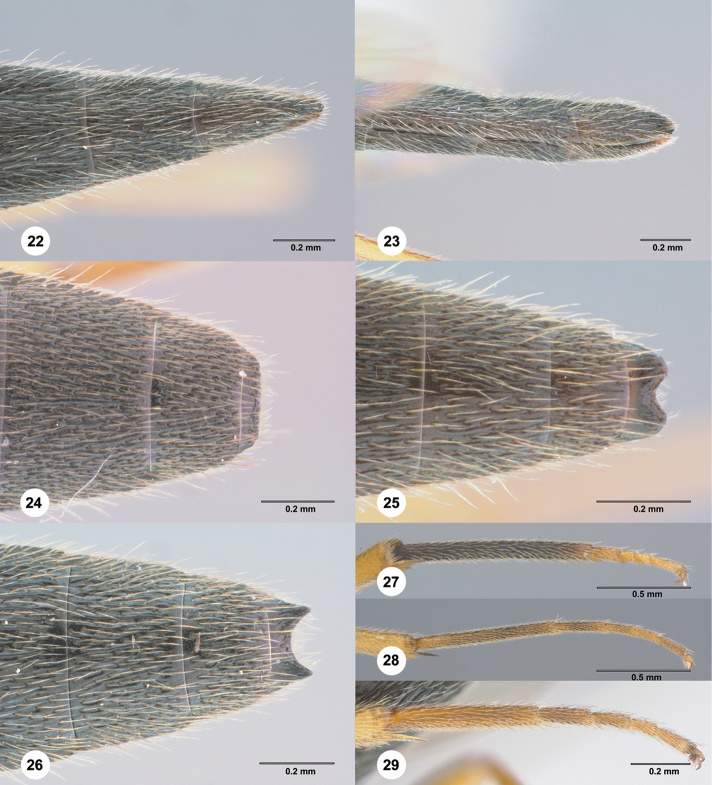
22–23Chromoteleiafuscicornis Kieffer, female (OSUC584322). 22 Apical metasoma, dorsal view 23 Apical metasoma, lateral view 24Chromoteleialongitarsis Kieffer, male, holotype (CAS TYPE9682), apical metasoma, dorsal view 25Chromoteleiafuscicornis Kieffer, male (OSUC586417), apical metasoma, dorsal view 26Chromoteleiabidens sp. n., male, paratype (OSUC577455), apical metasoma, dorsal view Apical 27Chromoteleialongitarsis Kieffer, female (OSUC584896), hind tarsus 28Chromoteleiadepilis sp. n., female, paratype (OSUC577436), hind tarsus 29Chromoteleiabidens sp. n., female, paratype (OSUC577455), hind tarsus.